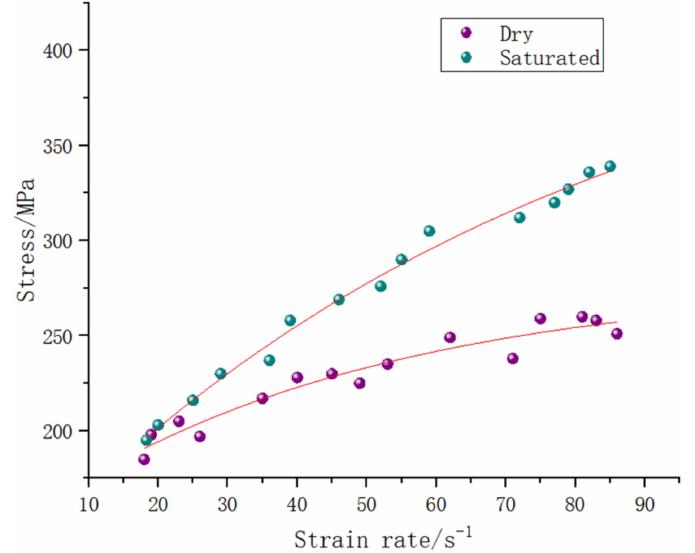
Figure 6. Dynamic strength curves of saturated and air-dried